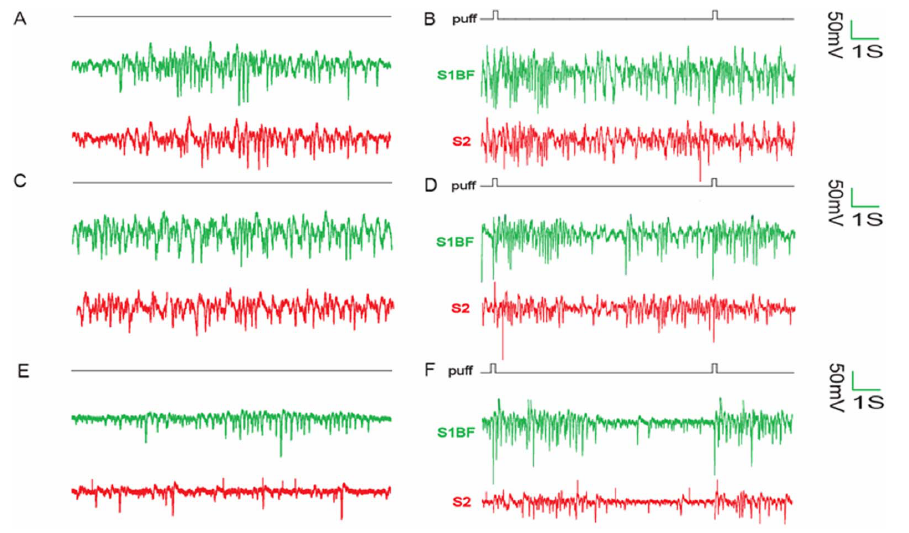
Figure 1. Simultaneous extracellular recordings in S1BF and S2 by different doses of propofol. Spontaneous activity (A, C, E) and whisker-triggered responses (B, D, F) were shown in different panels. Extracellular recording were performed in S1BF (green) and S2 (red). Panel A and